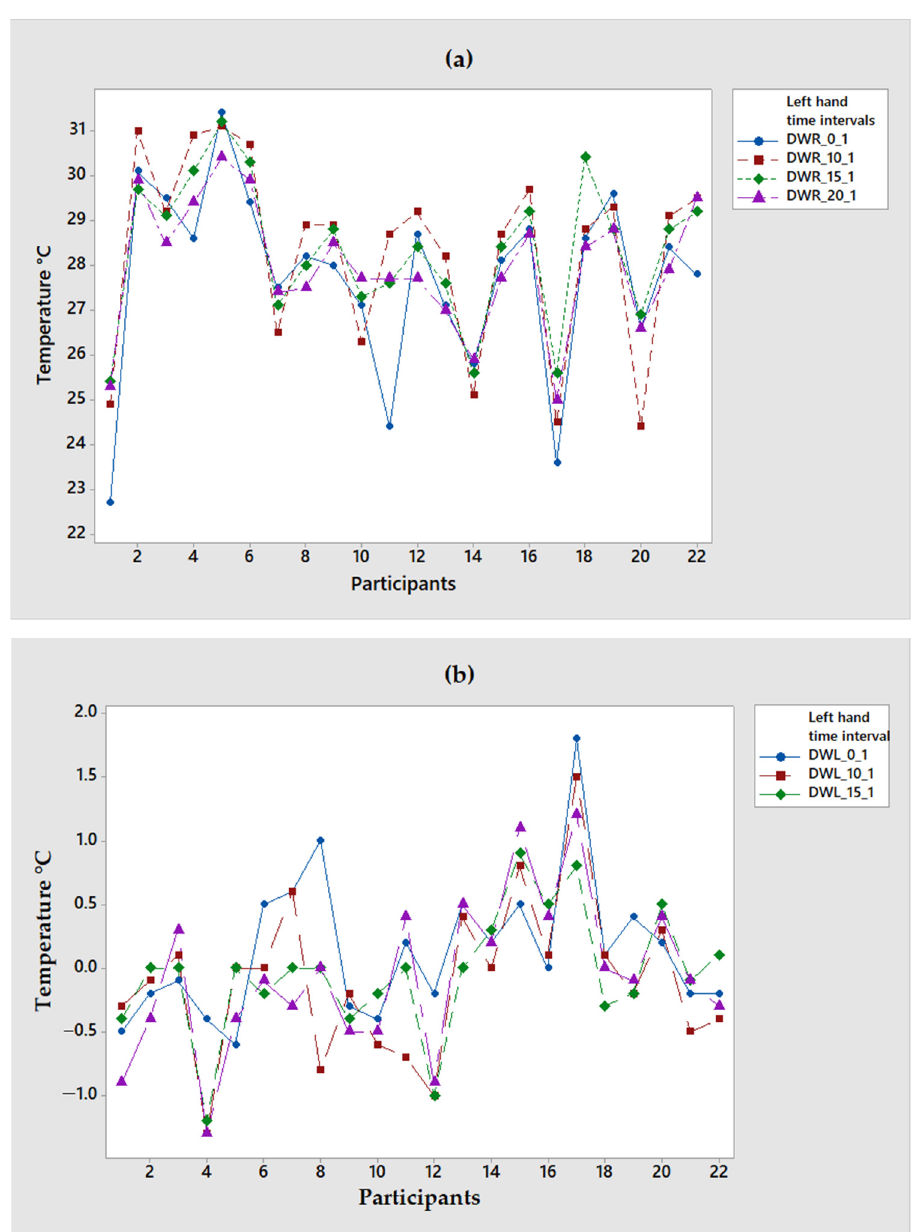
Figure 3. Temperature sample with IRT: ( a ) right-hand wrist temperature ( b ) left-hand tempera- ture.